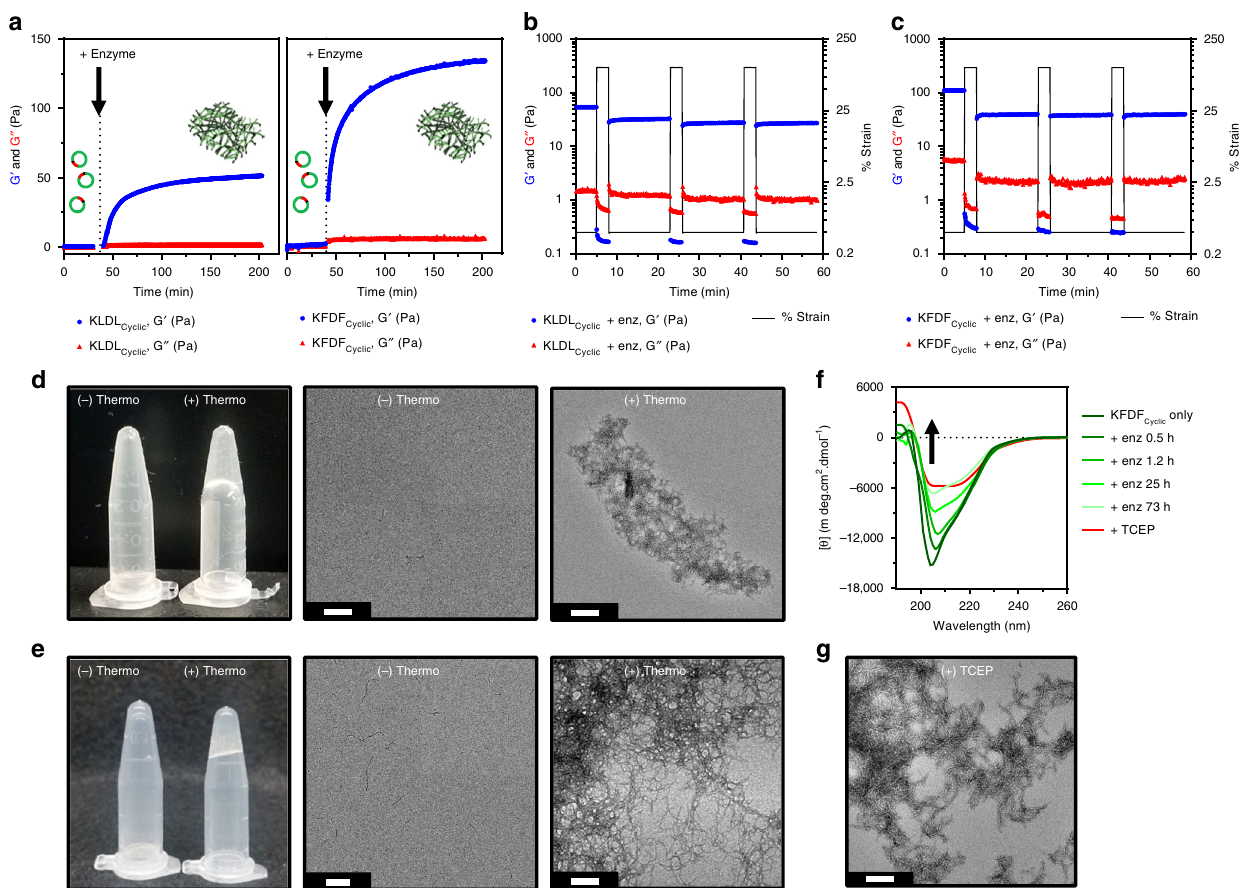
Fig. 6 Bulk scale gelation of unlabeled cyclic progelators. a Time course rheological analyses of KLDL Cyclic (left) and KFDF Cyclic (right) progelators before and after addition of thermolysin ( t = ~40 min). Divergence of G ’ (blue circles) from G ” (red triangles) (G ’ > G ” ) indicates formation of crosslinked hydrogel. Clipart adapted from Servier ’ s Medical Art database (https://smart.servier.com). b , c Step-strain oscillation plots of resulting ( b ) linearized KLDL and ( c ) linearized KFDF self-assembling peptide (SAP) hydrogels at 9 h post enzyme activation reveal repeat healing (3 min at 100% strain, 15 min at 0.5% strain, n = 3 cycles). Angular frequency 2.5 rad s − 1 , 0.5% strain. d , e Photographs of ( d ) KLDL Cyclic and ( e ) KFDF Cyclic progelators in the absence ( − ) and presence ( + ) of thermolysin with corresponding transmission electron microscopy (TEM). Enzyme cleavages at 10 mM in 1× Dulbecco's phosphate- buffered saline (DPBS) with 1:4500 enzyme/substrate molar ratio. TEM of samples diluted to 100 µ M. f Circular dichroism (CD) of KFDF Cyclic before and after subsequent additions of thermolysin (shades of green) at 0.5, 1.2, 25, and 73 h shows gradual disappearance of minimum around 204 nm from π – π * interactions between stacked cyclic peptides; 500 µ M peptide in 10 mM Tris, pH 7.4. g , Tris(2-carboxyethyl)phosphine (TCEP) (red, 1.2 eq)-induced reduction of progelator disul fi de bond shows ideal assembly of linearized progelators. Two minima at 204 nm ( π → π *) and 215 nm (n → π *) reveal weak aromatic π – π * interactions and β -sheets assembly, respectively; 500 µ M peptide in H 2 O, pH 7.4. Scale bars 200